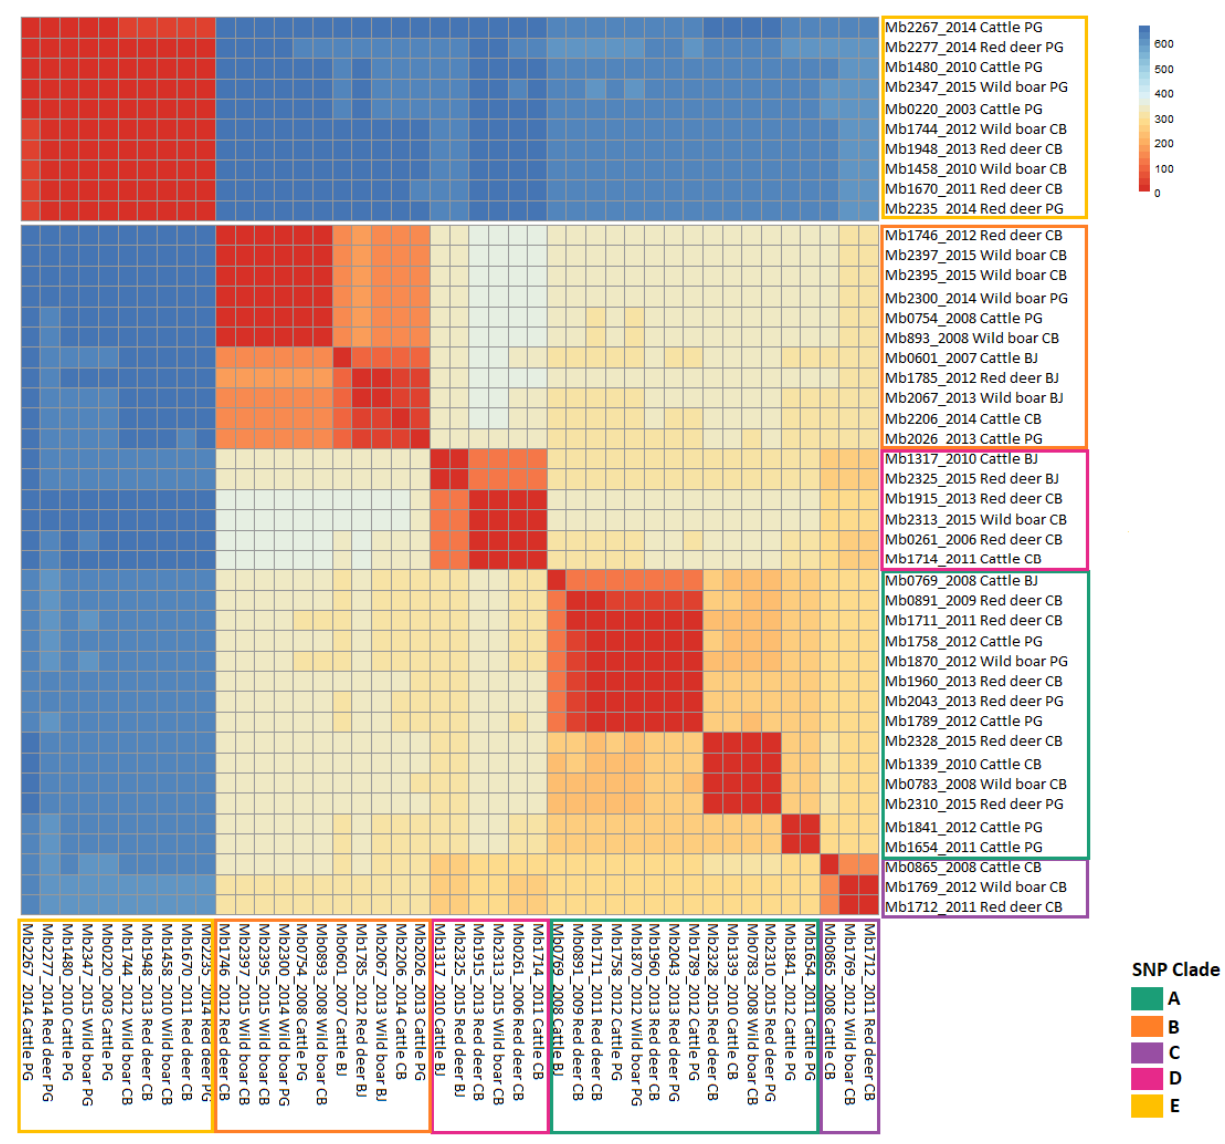
Figure 2. Heatmap of pairwise SNP distances based on the absolute distance of SNPs. The color of the boxes identifies the different SNP clades (A—dark cyan, B—orange, C—purple, D—pink and E—yellow).